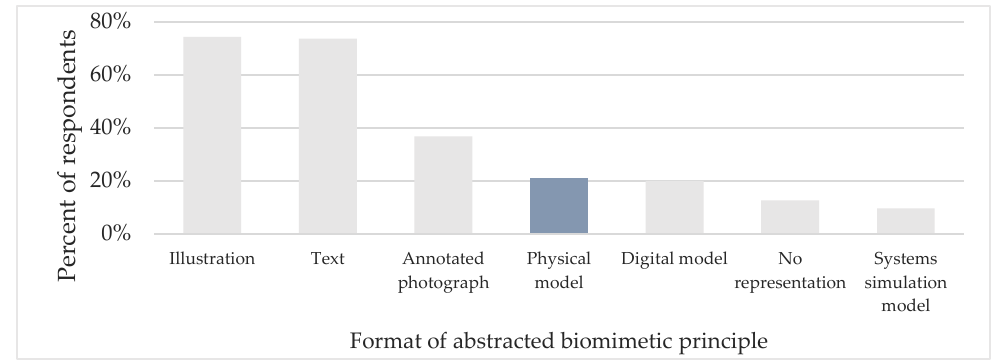
Figure 6. Formats used to represent abstracted biomimicry design principles as reported by surveyed practitioners.